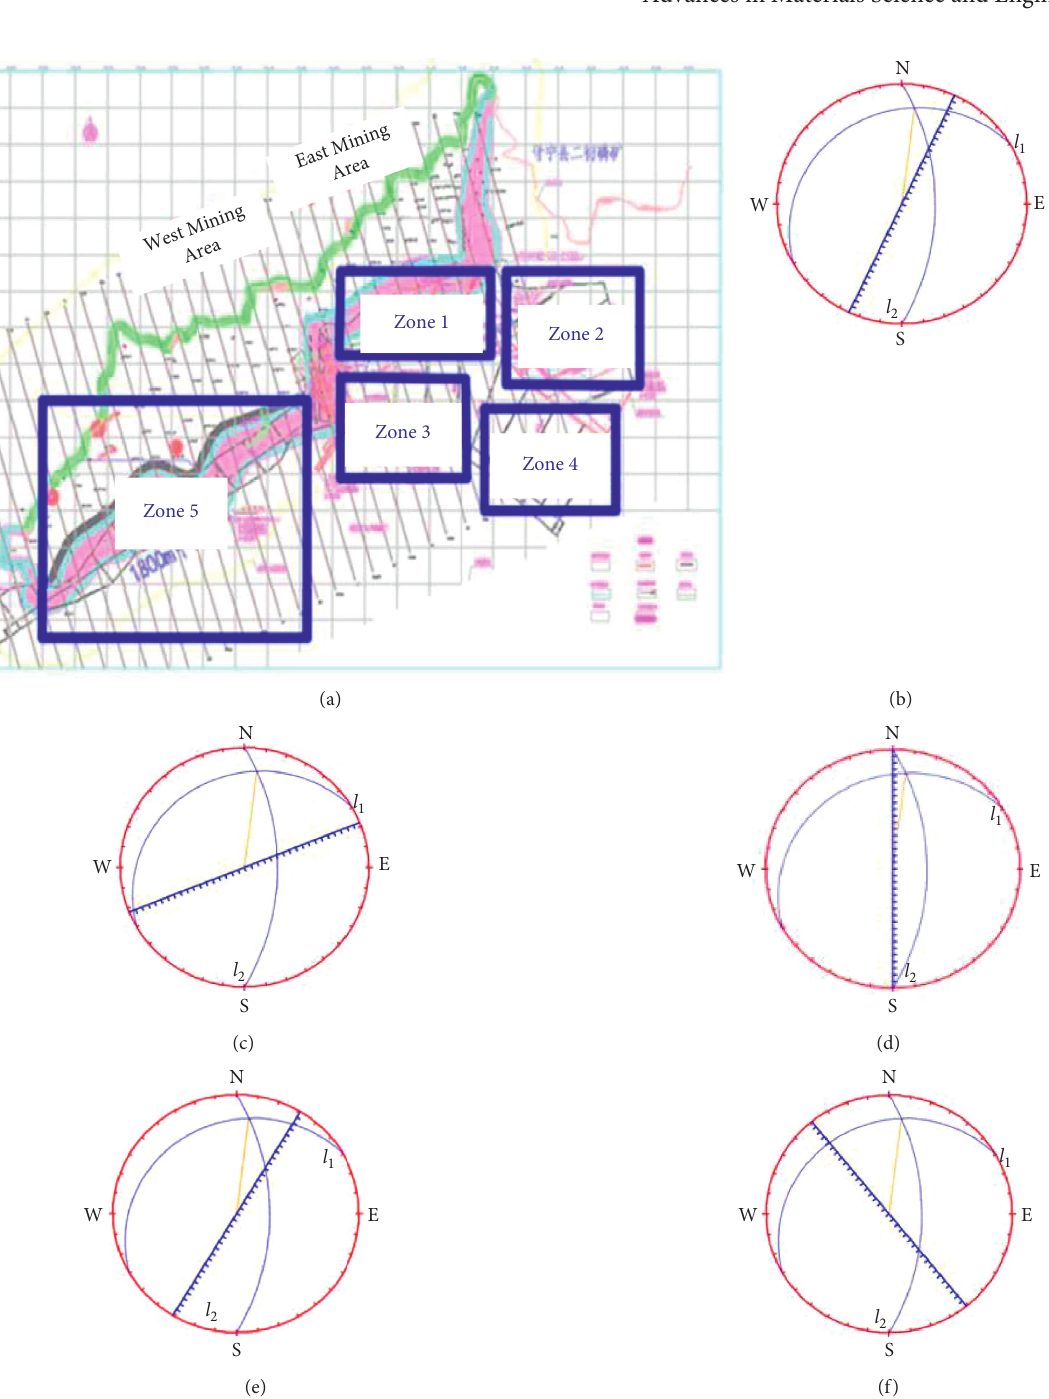
Figure 3: Stereographic projection of different regions. (a) Area division map; (b) stereographic projection in zone 1; (c) stereographic projection in zone 2; (d) stereographic projection in zone 3; (e) stereographic projection in zone 4; (f) stereographic projection in zone